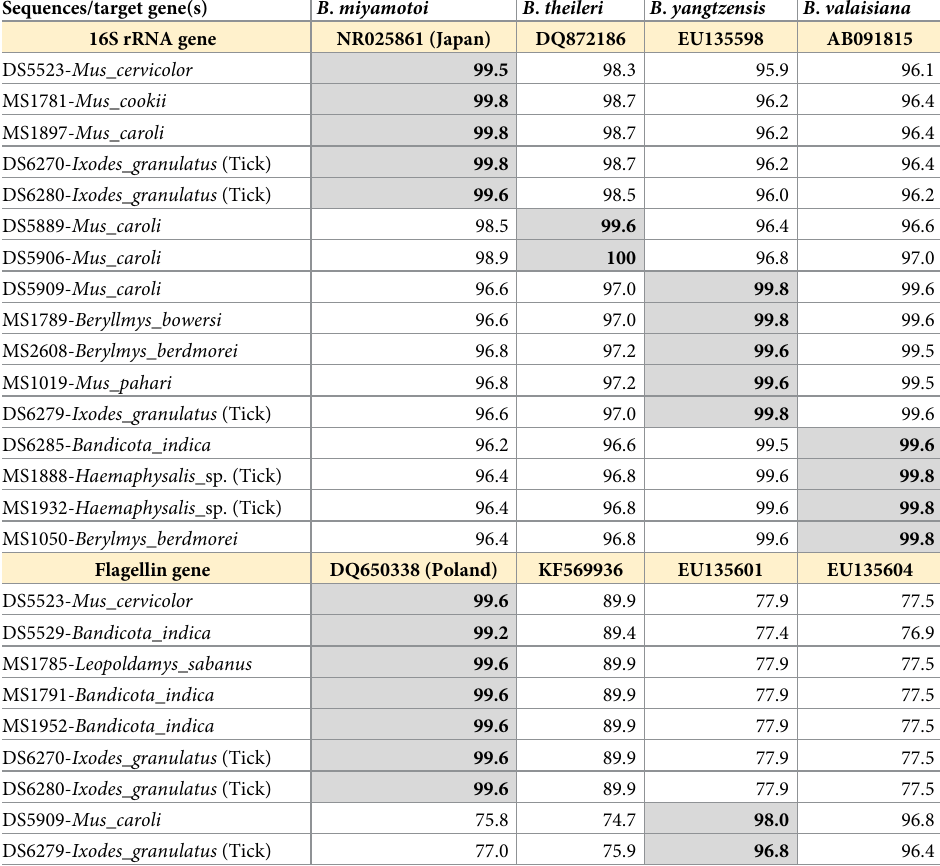
Table 2. Sequence identity matrix of Borrelia spp. detected in examined rodents and their associated ticks from Phop Phra District, Tak province (2019–2020). Sequences/target